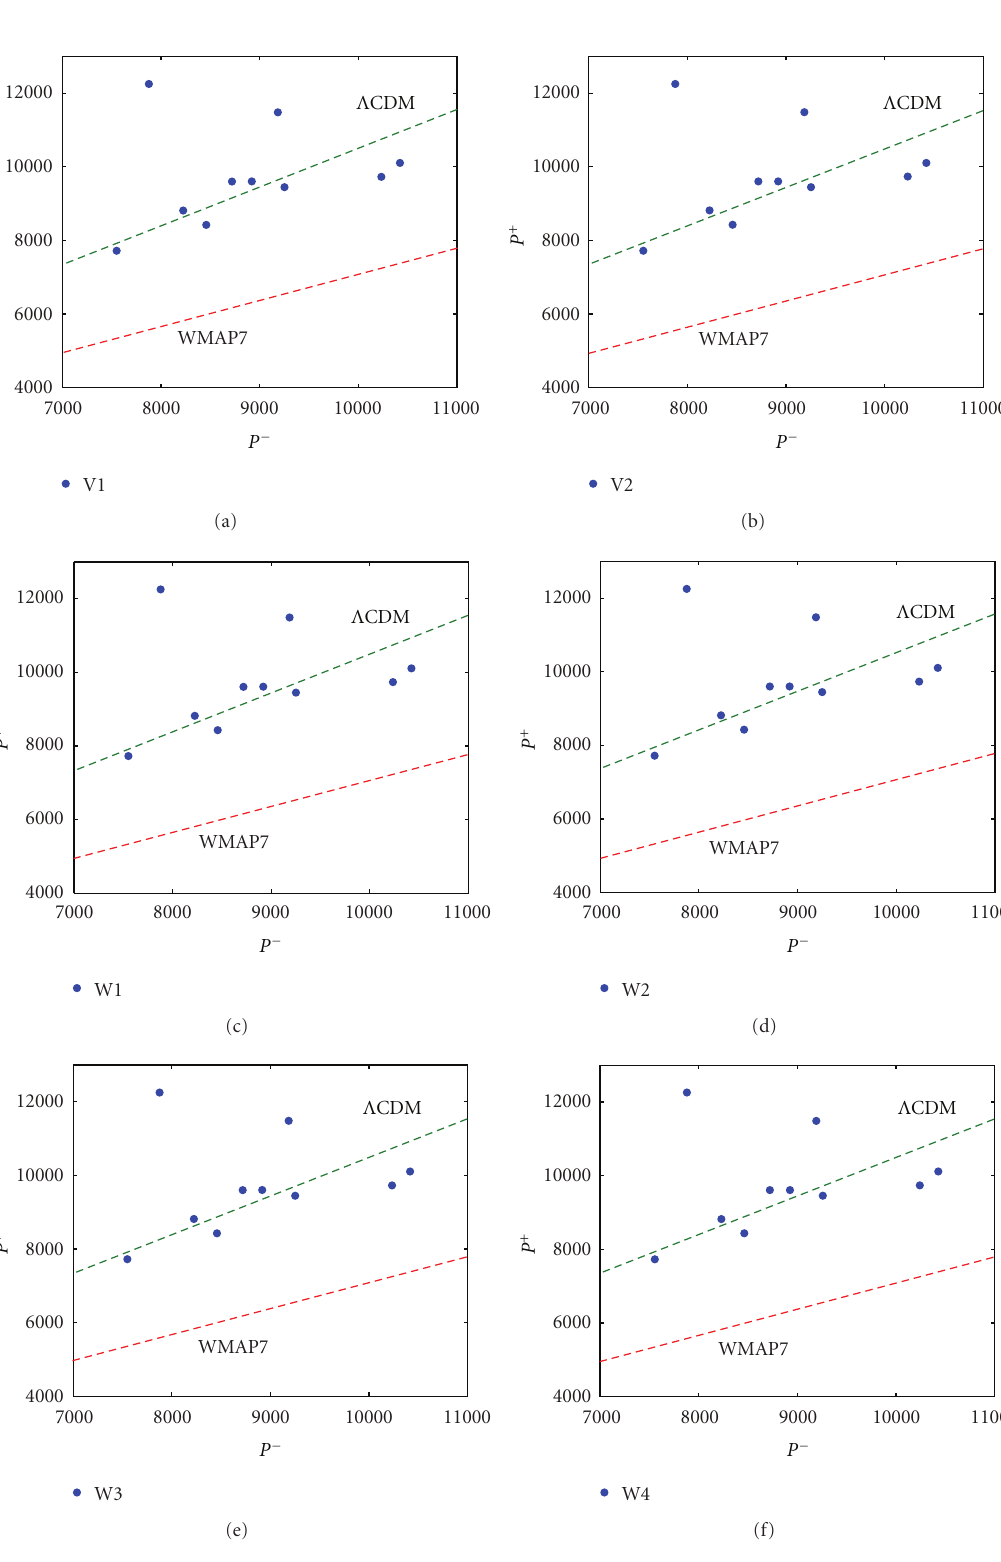
Figure 10: The parity asymmetry in the presence of beam asymmetry: the dots denote ( P + , P − ) of CMB maps simulated with asymmetric beams. The dashed lines are plotted with slopes corresponding to the P + /P − of Λ CDM model (red) and WMAP7 data (green), respectively. The alphanumeric values at the lower right corner denote the frequency band and D/A